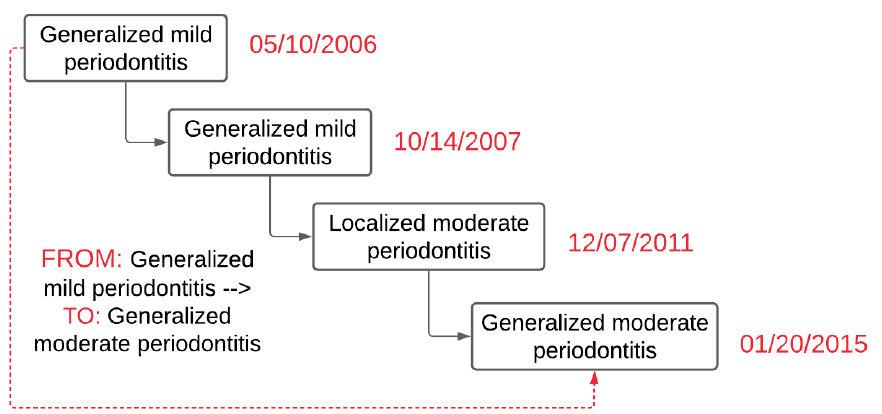
Figure 3. Example output of diagnosis change overtime classifier.py to determine PD change over time (a hypothetical case).